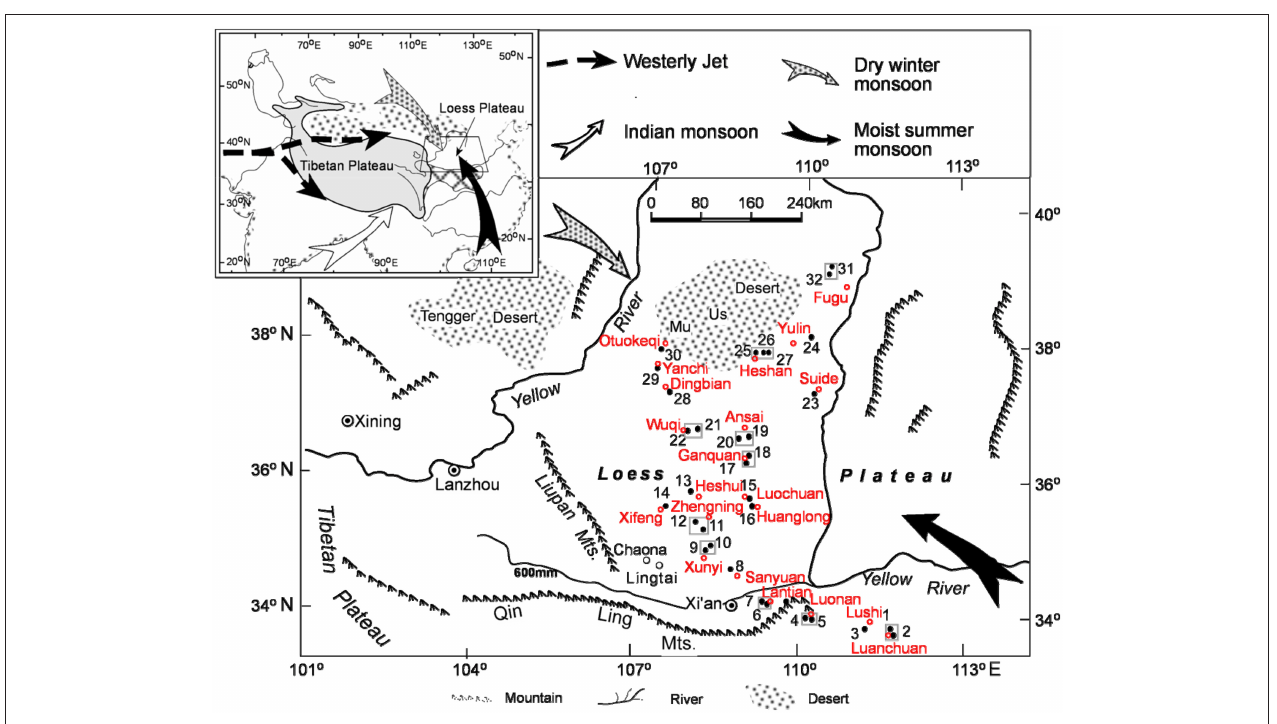
FIGURE 1 | Schematic map of the Chinese Loess Plateau and the location of the Chaona profile (black circle beneath Chaona), the Lingtai profile (black circle above Lingtai), surface soil samples (solid dots), and meteorological stations (red circles) used in this paper. The inset illustrates the location of the Chinese Loess Plateau relative to the Tibetan Plateau and the modern Asian atmospheric circulation. Magnetic parameter values were averaged for dots within the gray rectangle before comparing with the meteorological data closest to them. Modified from Song et al.